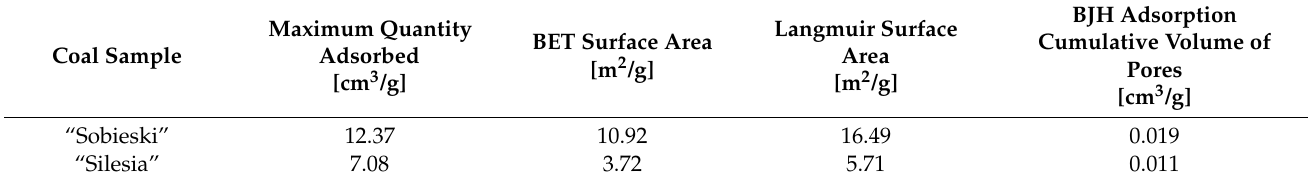
Table 2. The specific surface areas determined by BET and Langmuir models were about three times larger for the “Sobieski” sample in comparison with the “Silesia” sample. Table 2. Adsorption properties of